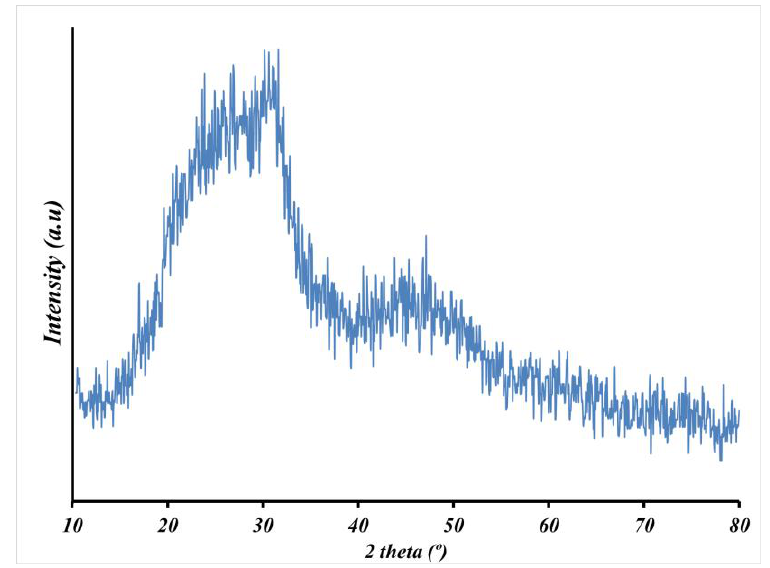
Figure 5. XRD spectra of the sintered Sr-BG nanofibers at 600 °C for 5